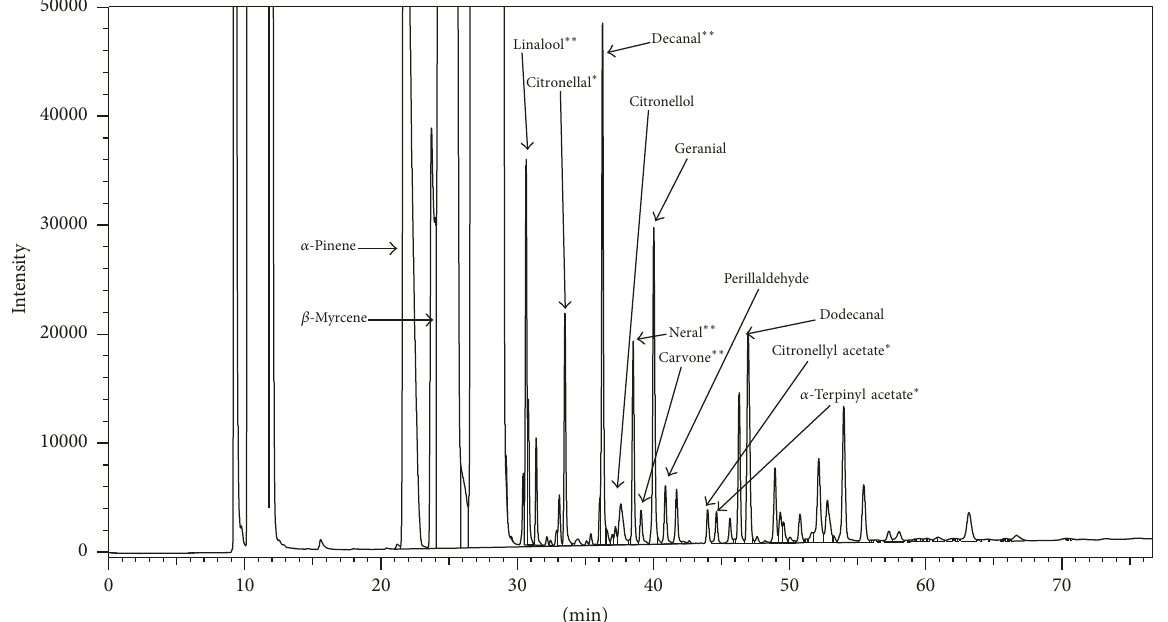
Figure1:ChromatogramfromHamlinEarlyAsymptomatic. Note .2-Decenaland2,4-decadienalarenotlabeledonthechromatogramasthey were not detected in this sample. ∗ Compound has lower concentration compared to HES. ∗∗ Compound has higher concentration compared to